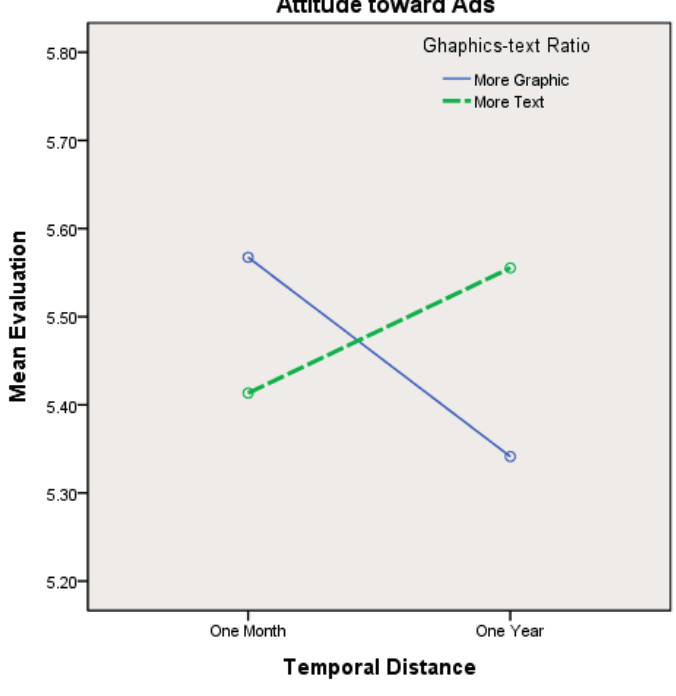
Figure 4. Interaction effects between temporal distance and the graphics-text ratio on attitude toward advertisement.